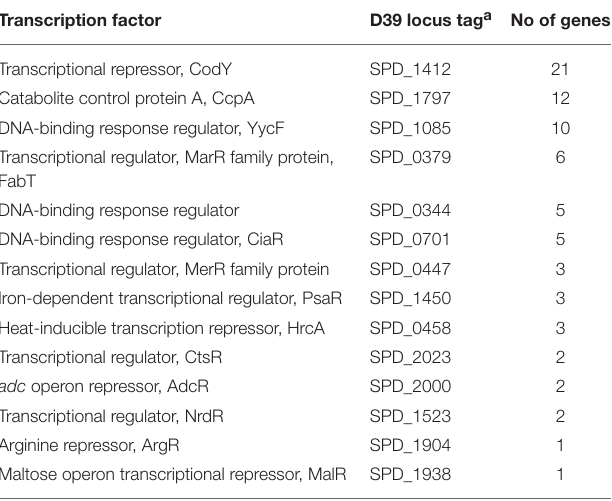
TABLE 1 | Clustering of genes significantly affected by 1 mM H 2 O 2 , by at least a factor of 1.8, according to their specific TF. Transcription factor